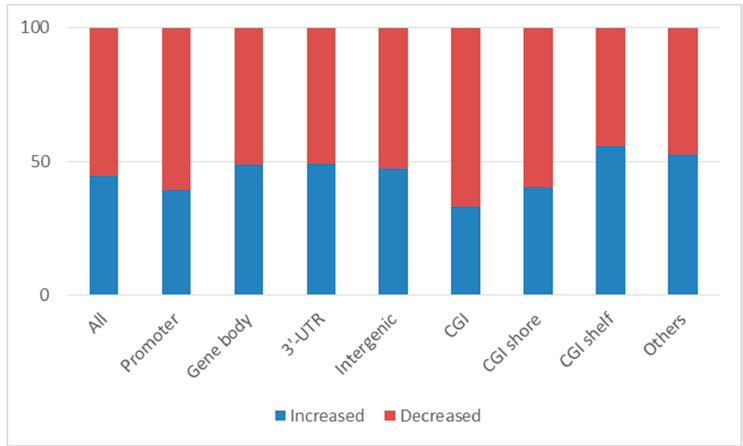
Figure 1. The proportions of CpG sites which showed increased or decreased DNA methylation changes after clozapine treatment. Of 29,134 significant CpG sites, clozapine caused an increased DNA methylation at 13,052 sites (44.8%) and decreased DNA methylation at 16,082 sites (55.2%). Of 29,134 significant CpG sites, 11,850 sites (40.7%) were located in the promoter regions (increased DNA methylation: 39.5%, decreased DNA methylation: 60.5%), 9479 sites (32.5%) in gene bodies (increased DNA methylation: 49.1%, decreased DNA methylation: 50.9%), and 864 sites (3.0%) in 3 ′ -UTRs (increased DNA methylation: 47.5%, decreased DNA methylation: 52.5%). Of 29,134 CpG sites, 7656 sites (26.3%) were located in the CGIs (CpG island) (increased DNA methylation: 33.1%, decreased DNA methylation: 66.9%), 7334 sites (25.2%) in CGI shores (increased DNA methylation: 40.3%, decreased DNA methylation: 59.7%), and 2846 sites (9.8%) in CGI shelves (increased DNA methylation: 55.9%, decreased DNA methylation: 44.1%).